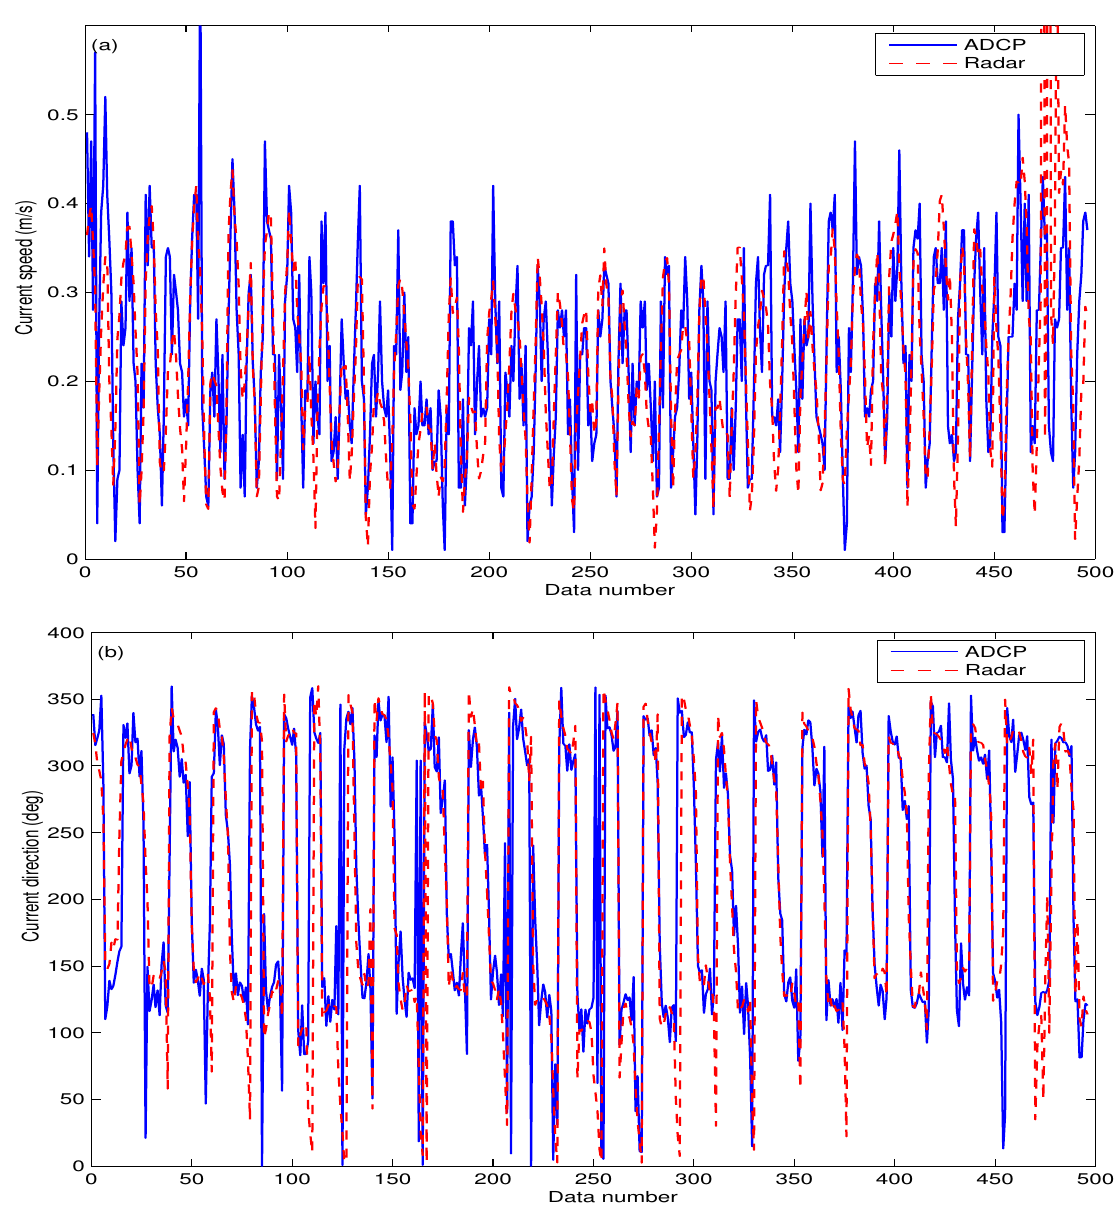
Figure 7. Comparison of ADCP-measured (at an 8-m depth) and radar-derived (iterative LS (ILS)) current: ( a ) speed; ( b )